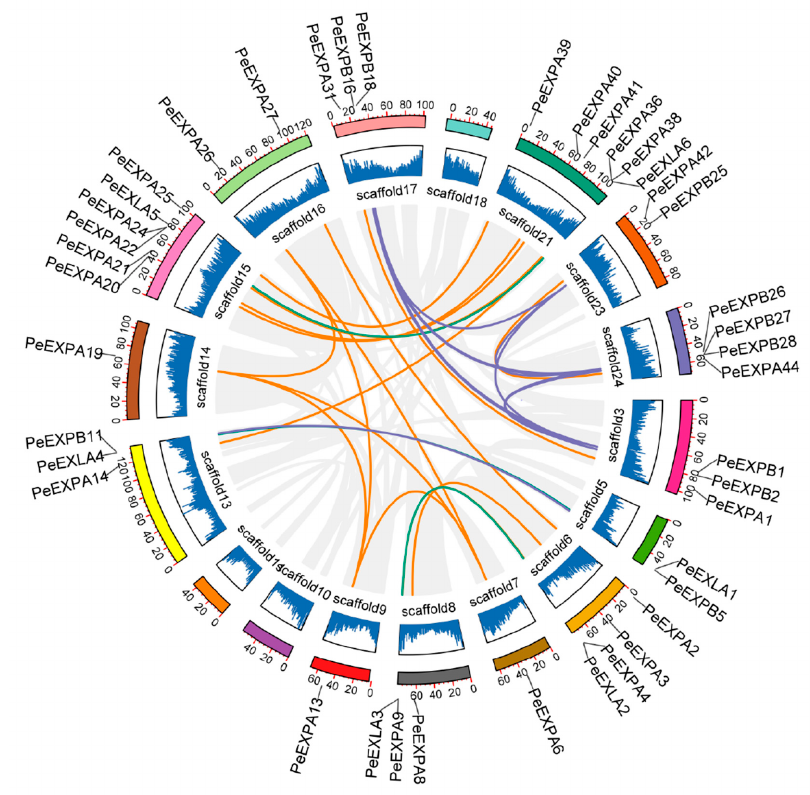
Figure 6. Syntenic analysis of expansin genes in moso bamboo. Different scaffolds are shown in different colors. The gene density is displayed in the form of histogram. The inner gray lines represent all the collinearity relationships in moso bamboo, and the inner orange, purple and green lines represent the collinearity relationships of EXPA, EXPB and EXLA subfamilies, respectively. A total of 31 pairs of segmented duplication genes were detected in the P. edulis genomes.